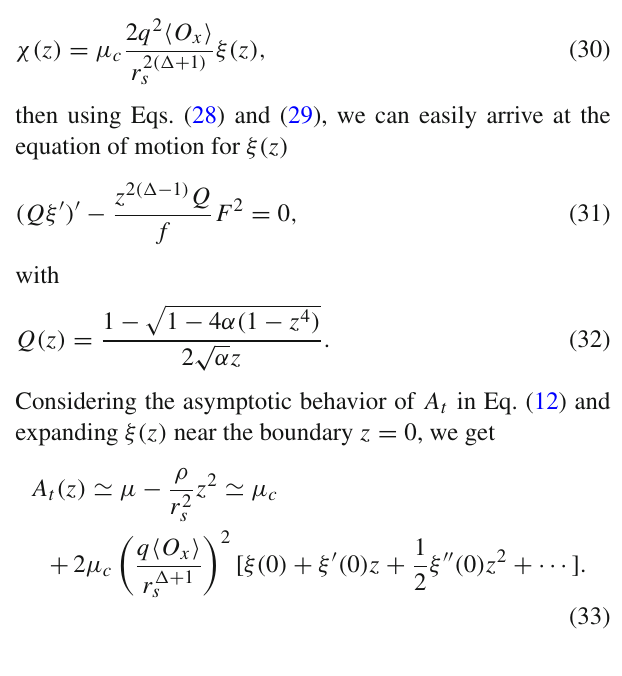
from left to right correspond to increasing superfluid velocity, i.e., K = qS ϕ / r s = 0 (black), 0 . 25 (blue), 0 . 50 (red), 0 . 75 (orange) and 1 . 00 (green) respectively. We scale q = 1 and r s = 1 in the numerical